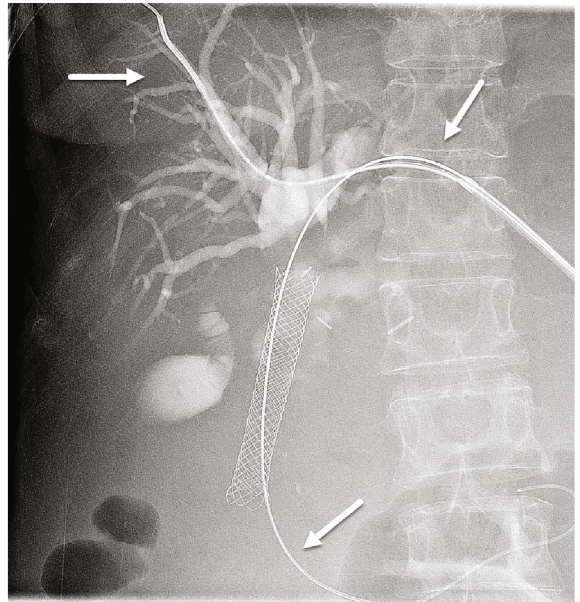
Figure 2: Exchange of internal external biliary drainage catheter for vascular sheath. Insertion of 2 guidewires, one each in the intrahepatic biliary radicles and one in the duodenum (long arrows).